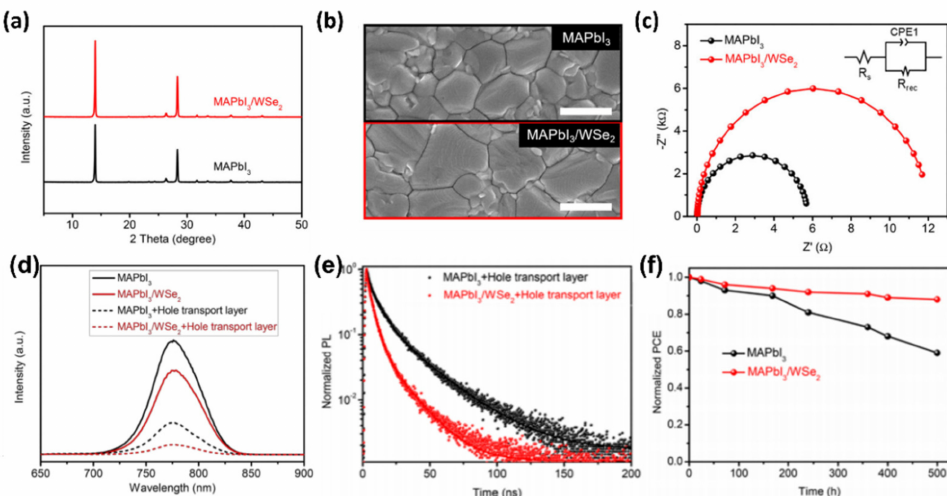
Figure 6. ( a ) XRD patterns of MAPbI 3 and MAPbI 3 /WSe 2 films; ( b ) SEM images of MAPbI 3 and MAPbI 3 /WSe 2 films; ( c ) Nyquist plots of MAPbI 3 and MAPbI 3 /WSe 2 -based PSCs; ( d ) PL spectra of the MAPbI 3 and MAPbI 3 /WSe 2 films with and without hole-transporting layer (HTL); ( e ) TRPL decay curves of the MAPbI 3 +HTL and MAPbI 3 /WSe 2 +HTL structures; ( f ) Photostability of non- encapsulated MAPbI 3 and MAPbI 3 /WSe 2 based PSC devices under storage in N 2 glovebox (illu- mination of 100 mW cm − 2 white light-emitting diode (LED) for 500 h). Data taken from ref.